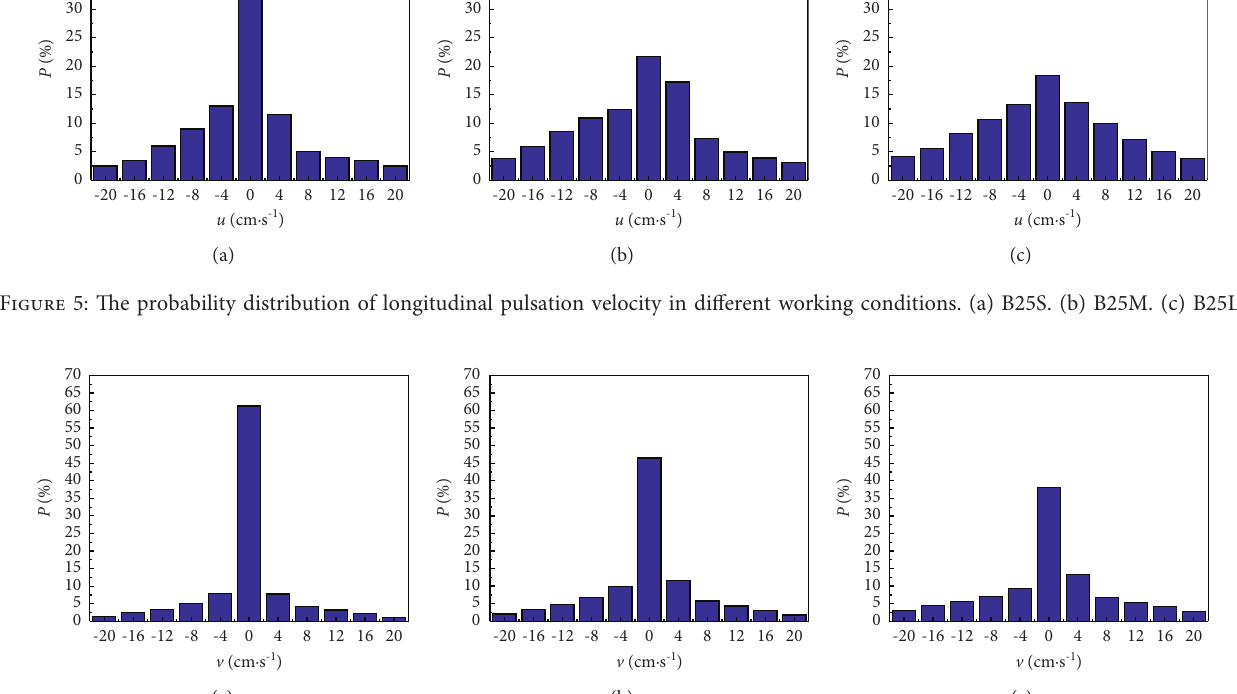
-20 -16 -12 -8 -4 0 4 8 12 16